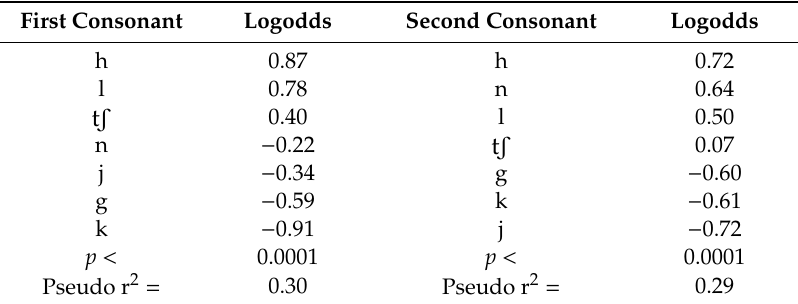
Table 2. Relationship between phones and smooth and jerky